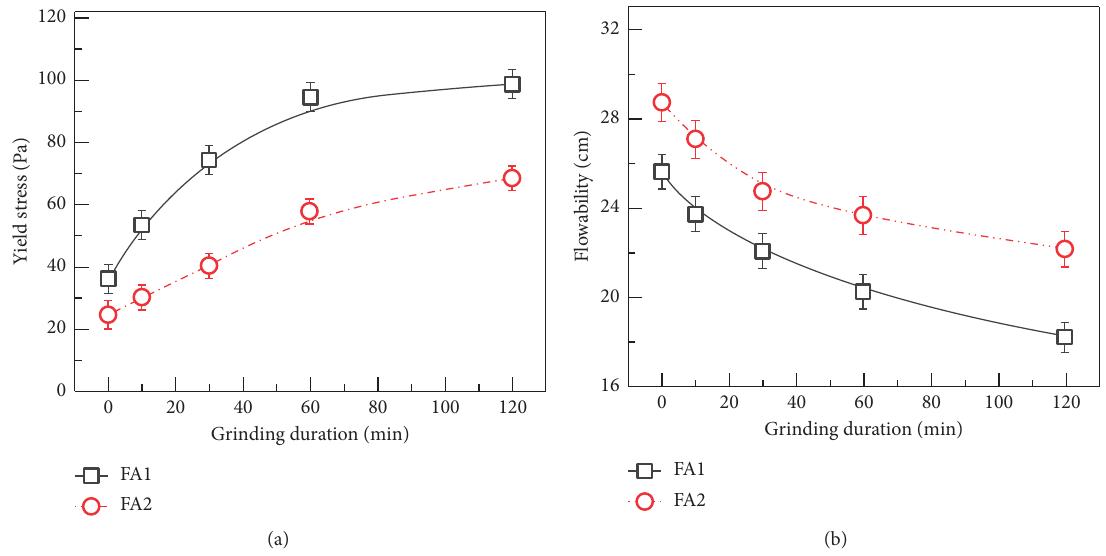
Figure 10: Rheological properties of the fresh slurry: (a) yield stress and (b) flowability.